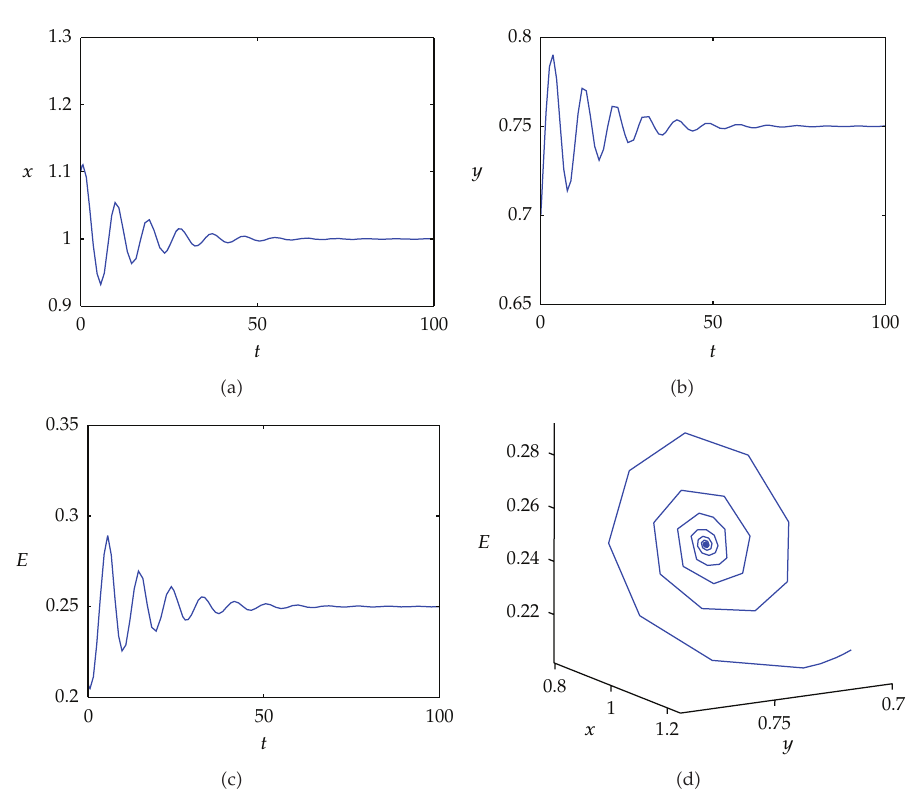
Figure 3: When τ (cid:5) 1 . 3, the positive equilibrium point Y 0 is